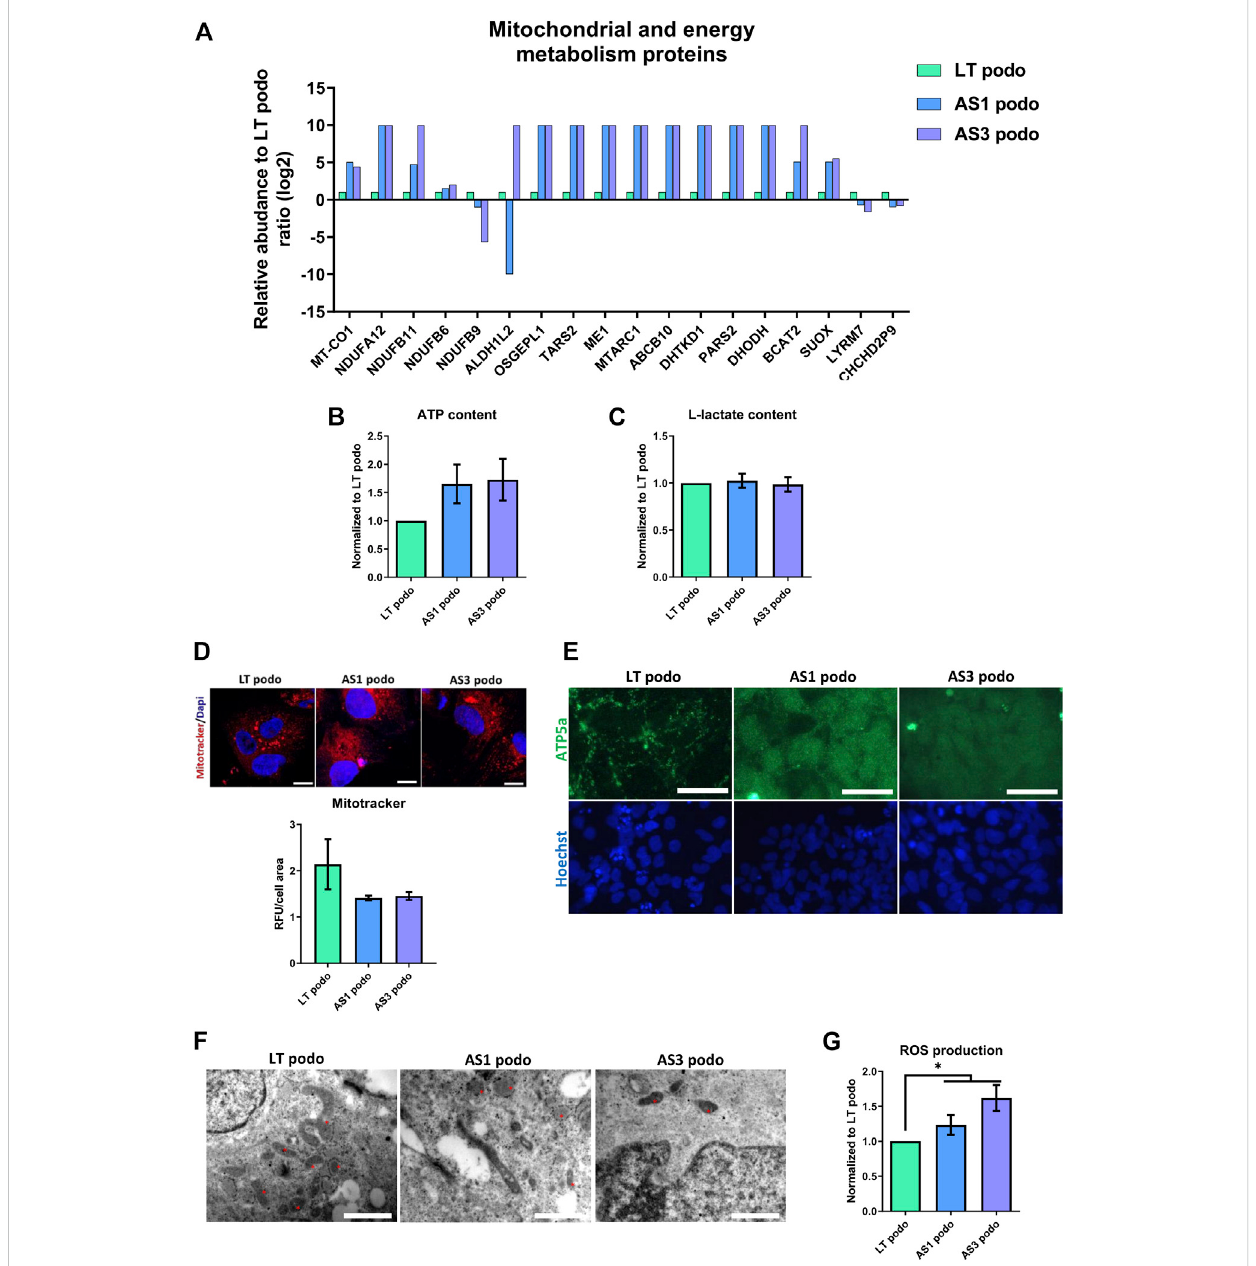
FIGURE 6 Metabolism in Alport Day 14 podocytes. In (A) , several proteins involved in mitochondrial metabolism were dysregulated in Alport cell lines. No statistical difference was observed in ATP content (B) , L-Lactate production (C) or mitochondrial membrane potential (IF, scale bar 20 μ m, the MitoTracker fl uorescentintensity wasnormalized overcells areafor quanti fi cation) (D) .However,mitochondrialmorphologyvaried among thecell lines, as demonstrated by ATPase IF, scale bar 50 µm (E) , and electron microscopy (F) . In EM the morphology of mitochondria (asterisks) in the different cell lines is highlighted; magni fi cation 250,00X for LT podo and 200,00x for AS podo fi gure, scale bar respectively 400 nm and 500 nm. Alport cell lines produced more reactive oxygen species than LT control podocytes (G) . Signi fi cance was tested by an unpaired t -test. Asterisk denotes statistically signi fi cant differences compared to LT control podocytes,* p < 0.05, n =